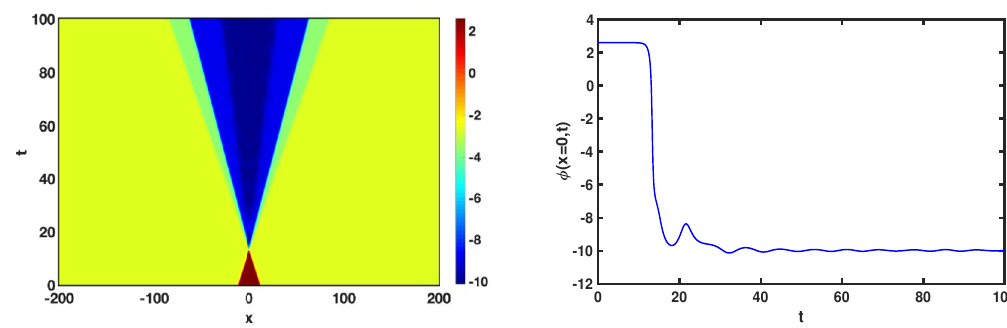
Figure 10 . Large kink-antikink collision showing: a) the changing of the topological sector and the production of a large antikink-kink pair. b) The scalar field profile at x = 0. In the both figures, r = 0 . 85 and v = 0 . 9.